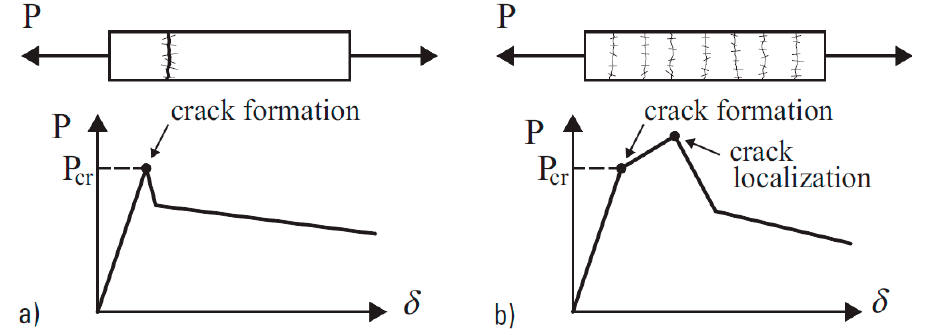
Figure 6. Simplified load-deformation curves; ( a ) strain softening, and ( b ) strain hardening [37].